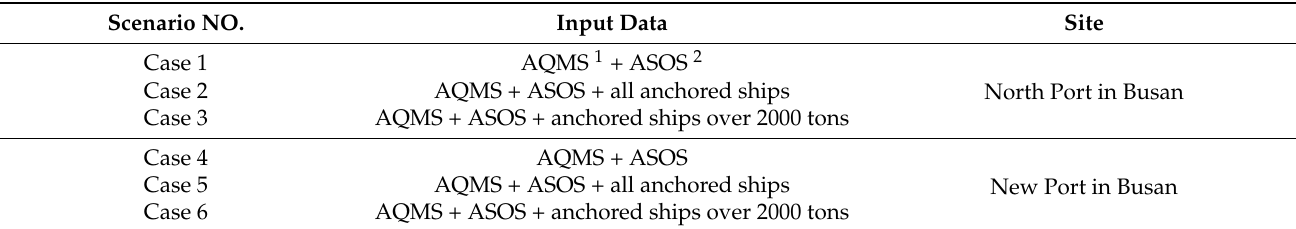
Table 5. Air quality prediction scenarios (learning and verification period: 1 January 2019 to 31 January 2020; prediction period: 1 February 2019 to 29 February 2020). Scenario